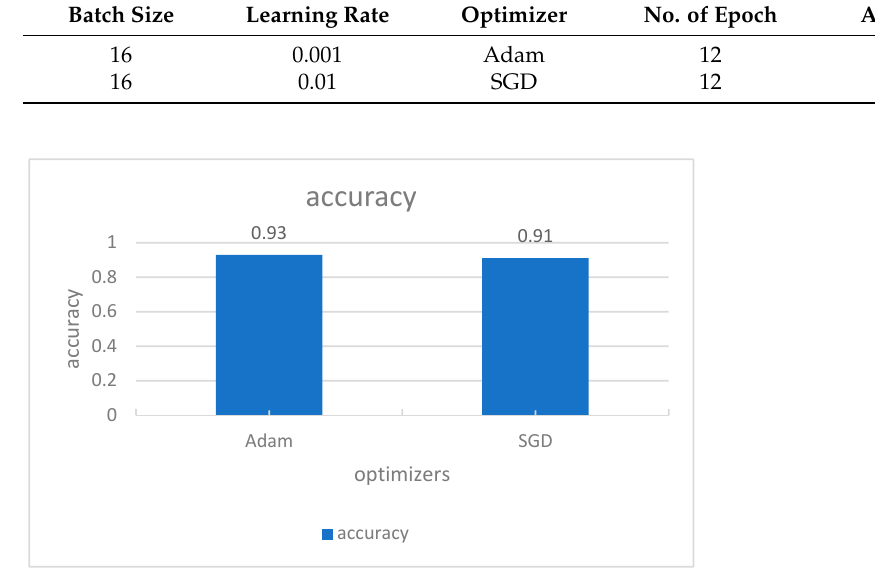
Figure 6. Comparison between Adam and SGD optimizer of ship detection .